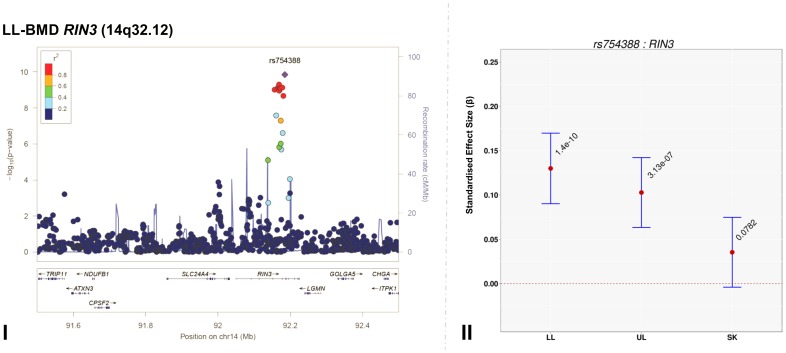
Regional association plot of the primary signal (rs754388) associate with lower limb-BMD at 14q32.12, in addition to a comparison of the effect of rs754388 on bone mineral density at three different skeletal sites.For I and II: Circles show GWA meta-analysis P-values and positions of SNPs found within the 14q32.12 locus. The top SNP, i.e. rs754388, is denoted by a diamond. Different colours indicate varying degrees of pair-wise linkage disequilibrium (HapMap 2 CEPH) between the top SNP and all other SNPs. For II: The per-allele effect in standard deviations (SD) (red dot) and the 95% confidence interval (error bar) of rs754388 for lower limb (LL), upper limb (UL) and skull (SK) BMD, plotted with the strength of evidence against the null hypothesis of no association.